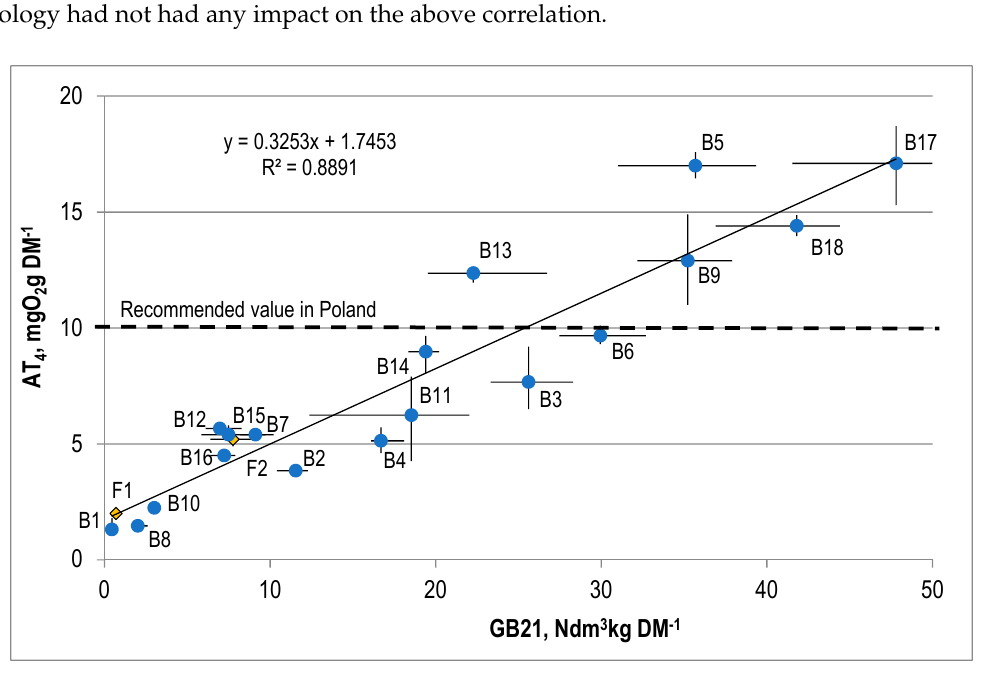
Figure 4. The correlation between AT4 and biogas potential (GB21) for the stabilized waste.